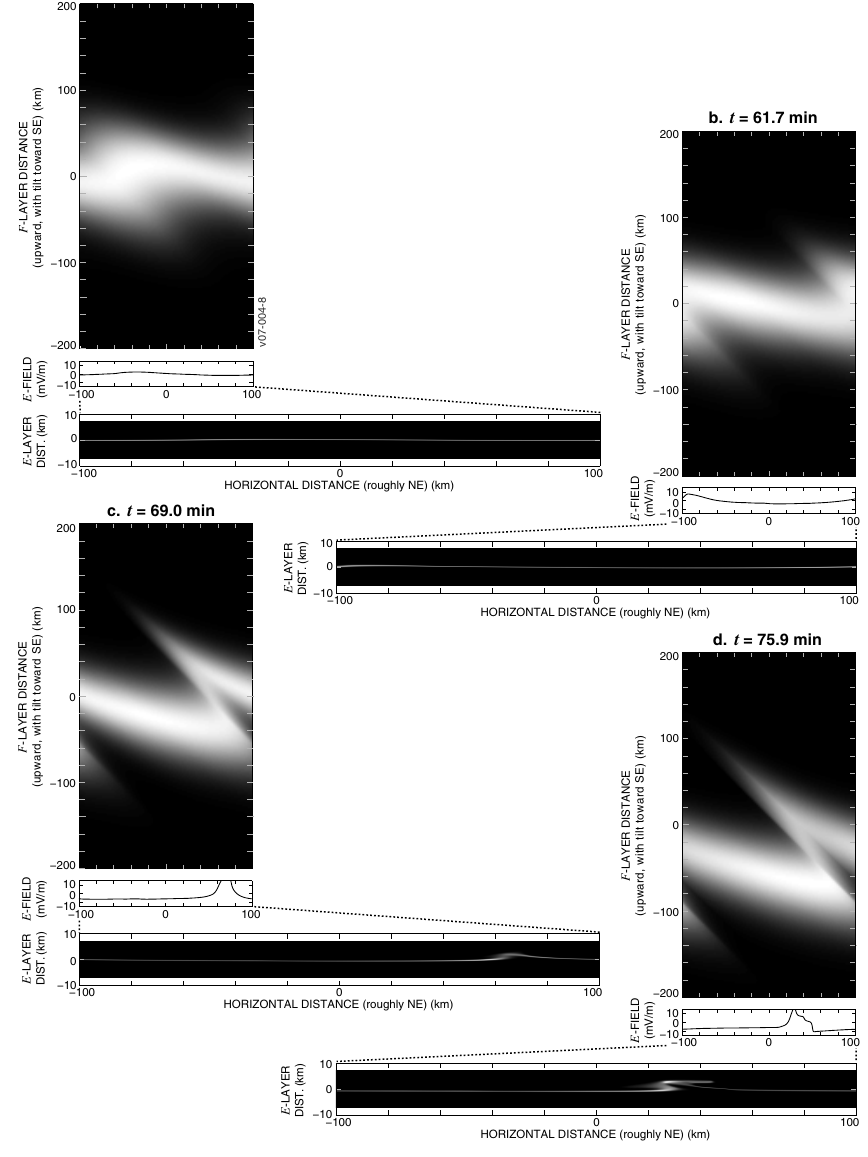
Figure 12: Coupled system evolution under non-resonant condition, with Σ H Σ = 3 . 0, and the E s layer at 103 km altitude. The boundaryconditions are periodic in the horizontal direction. The axes are described in thefirst paragraphs of Section 4, and summarized in Figure 3.